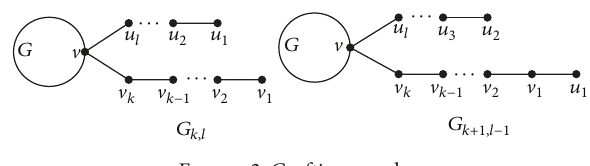
Figure 2: Grafting an